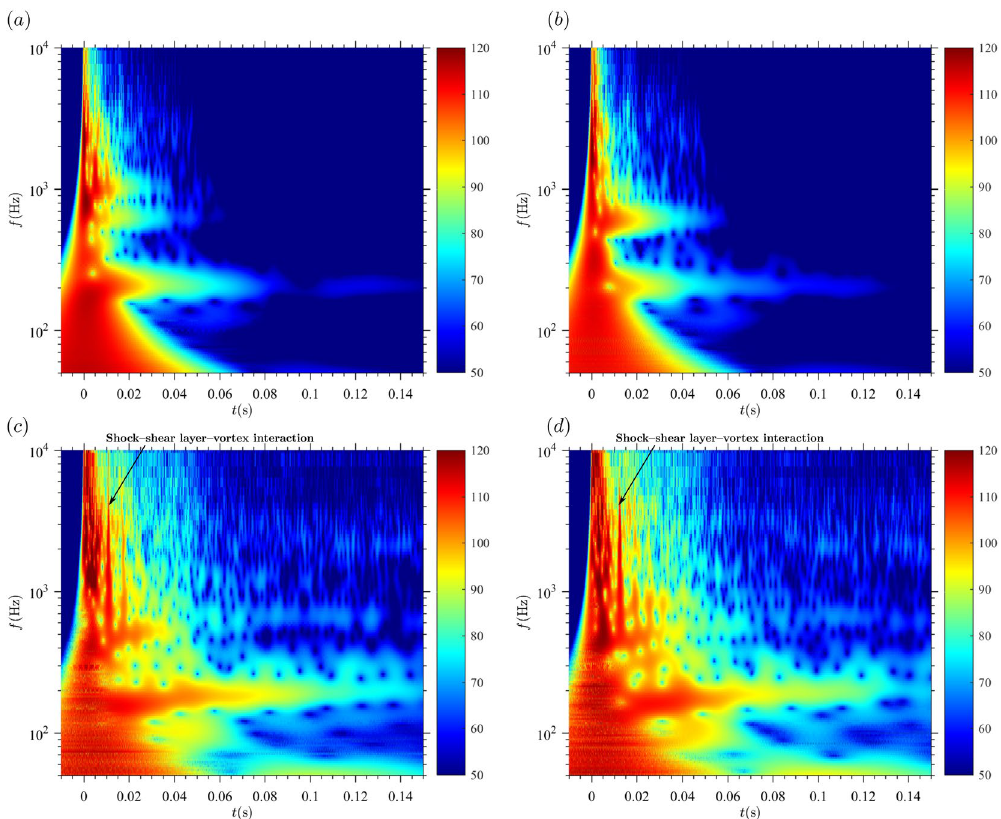
Figure 4. Effect of the pressure ratio on the acoustic signature of the shock-tube in the wavelet diagram. The color scale represents the sound pressure level [dB] at the microphone location. Ae/A* = 1 and L/D = 8. ( a ) p r / p ∞ = 3. ( b ) p r /p ∞ = 4. ( c ) p r /p ∞ = 50. ( d ) p r /p ∞ =